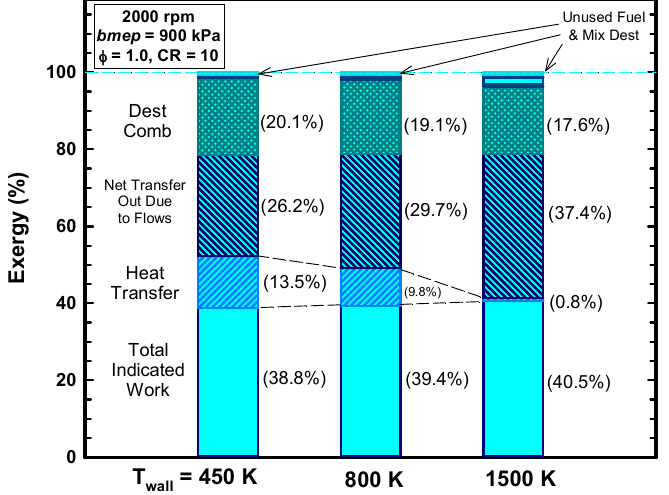
Figure 10. The fuel exergy distribution for three cylinder wall temperatures.